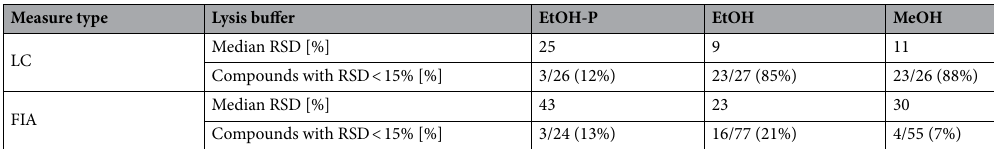
Table 3. The median relative standard deviation (RSD) of the individual compounds in HOS cells and the percentage of compounds with a RSD < 15% threshold (in total and in % from detected number) for liquid chromatography (LC) and flow injection analysis (FIA) mass spectrometry. Five replicates were measured in each condition; outliers were removed from the final analysis as described in the materials and